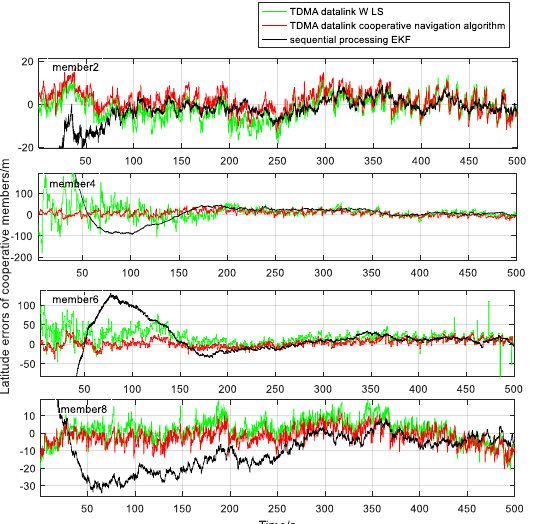
Figure 12. Longitude error comparison between TDMA datalink cooperative navigation algorithm, sequentially processing EKF, and TDMA datalink WLS.